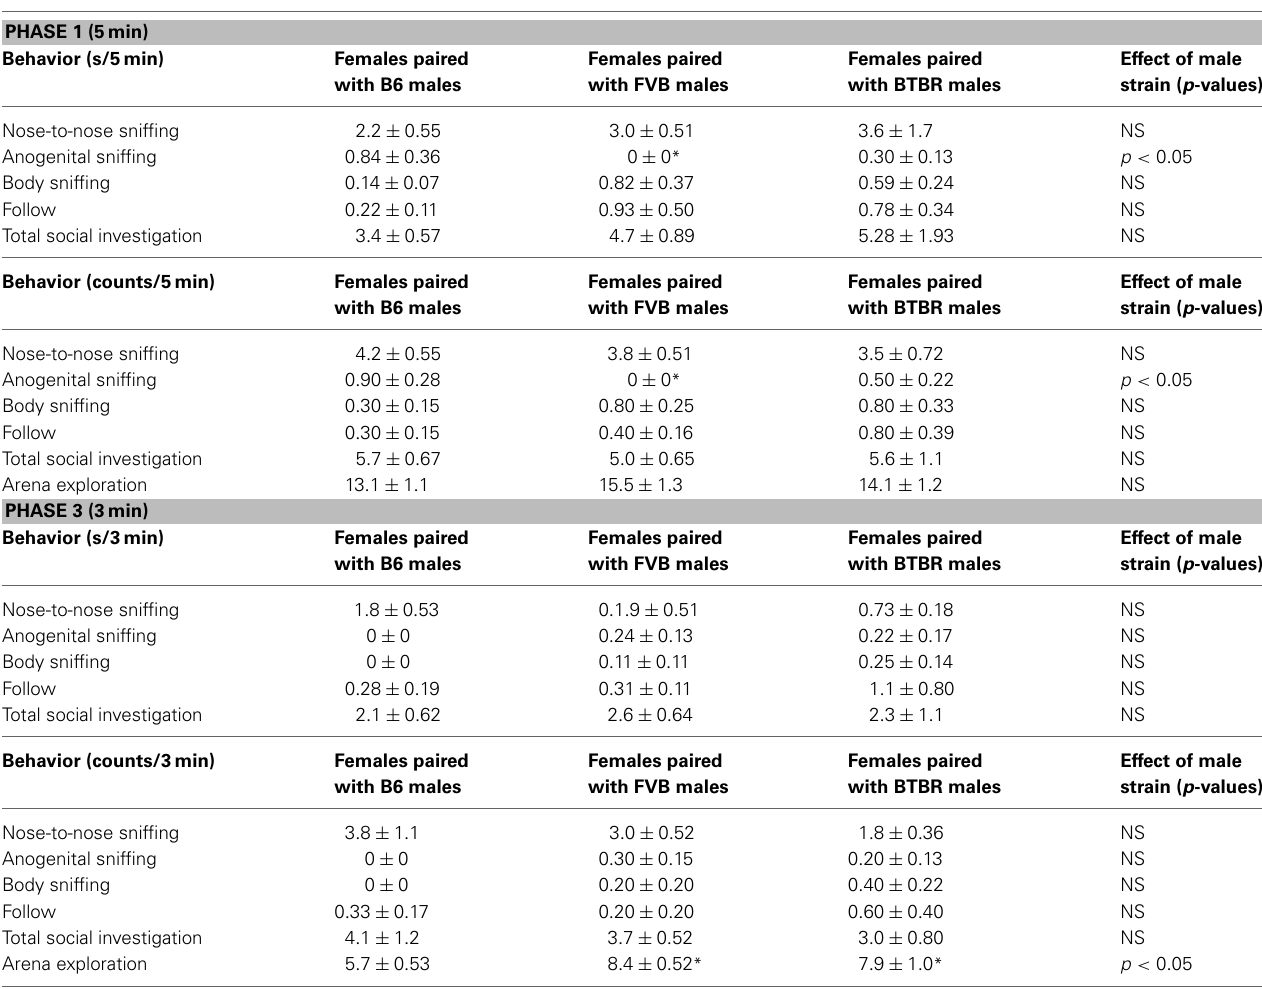
Table 3 | Behaviors of stimulus B6 females during phase 1 and phase